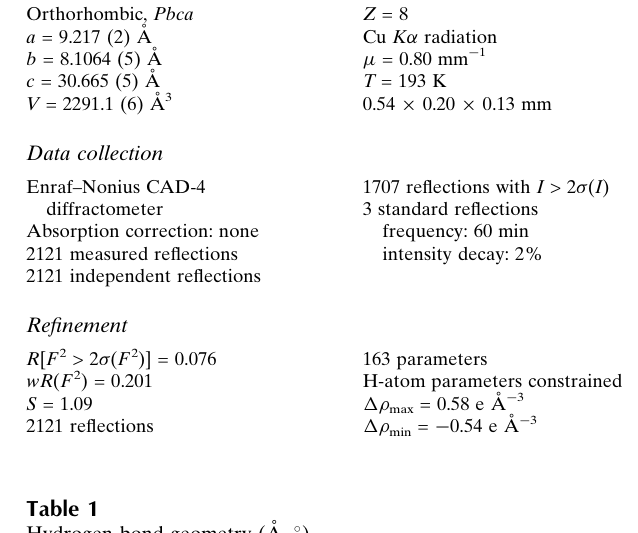
Hydrogen-bond geometry (A˚ , (cid:1)